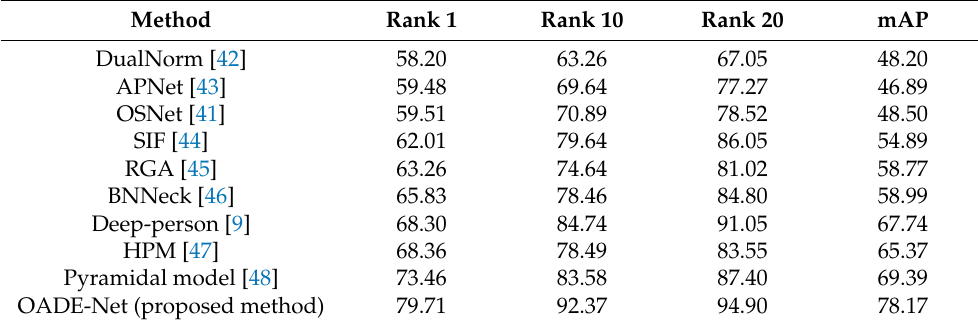
Table 6. Comparisons of the ReID accuracies by the proposed method and state-of-the-art methods with DBPerson-Recog-DB1 (unit: